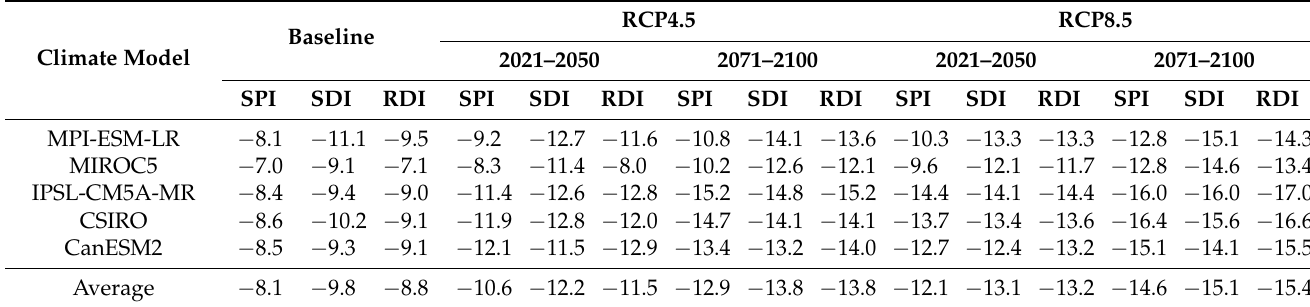
Table 3. Average drought magnitude for Bilate watershed calculated from SPI, SDI, and RDI.